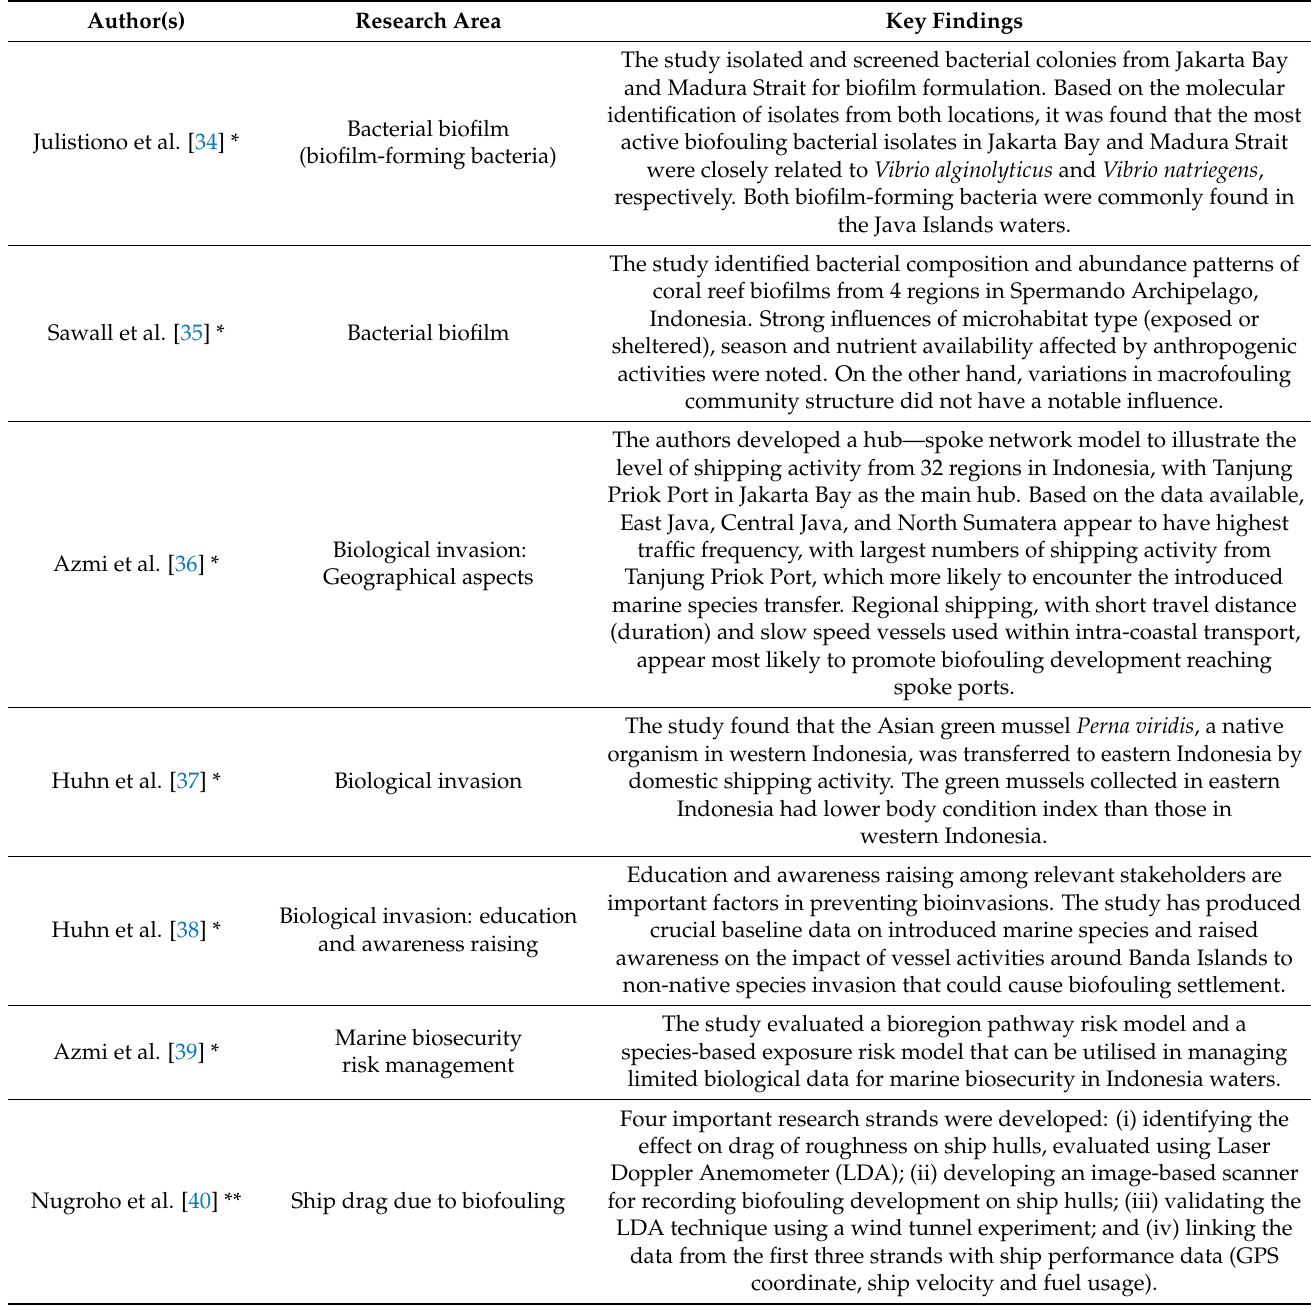
Table 1. Key biofouling studies using Indonesia as a case study